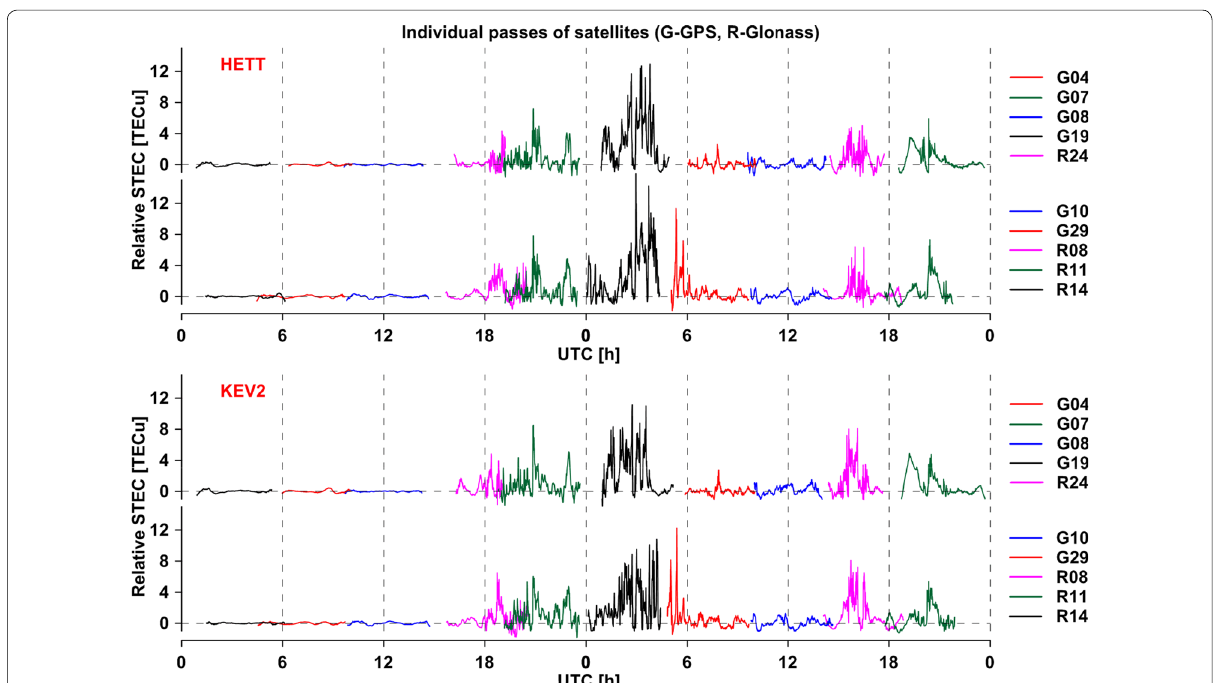
Fig. 3 The relative STEC values derived for the selected satellites on August 25–26, 2018. Top panel station HETT, bottom panel station